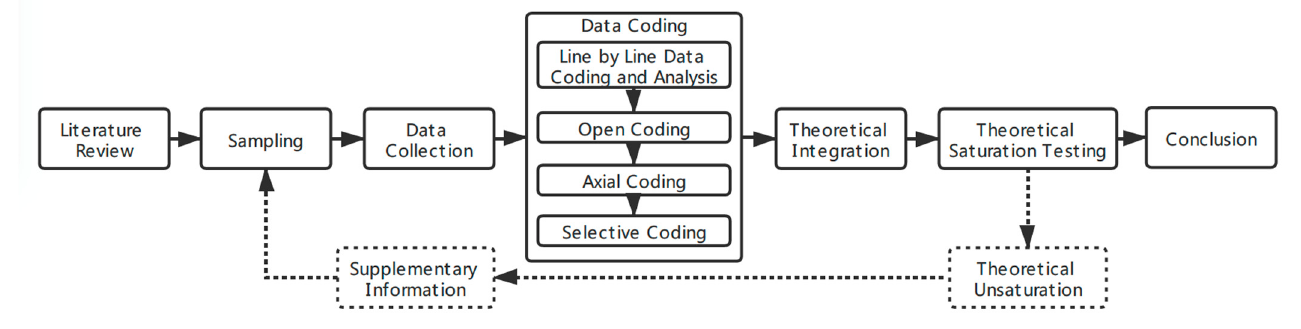
Figure 1. Research Process.